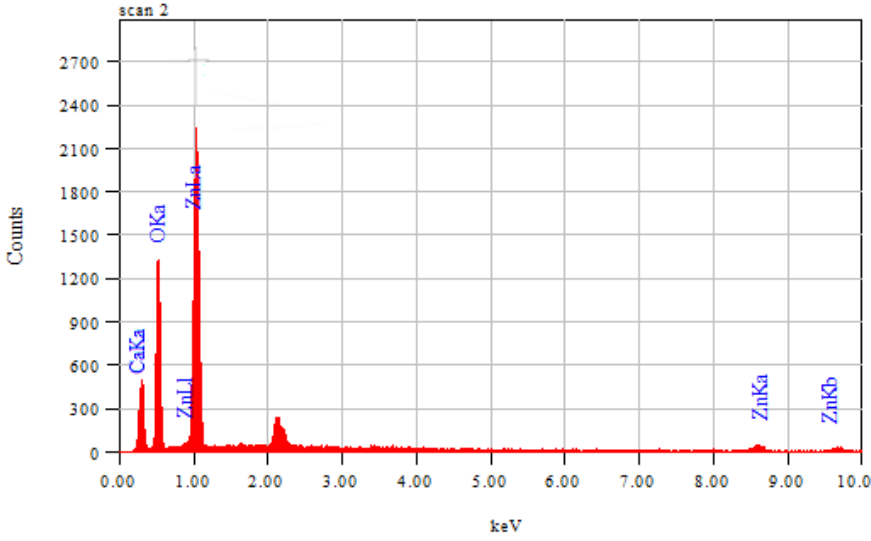
Figure 7. EDX spectrum of the seeded Ca-doped ZnO nanorods.